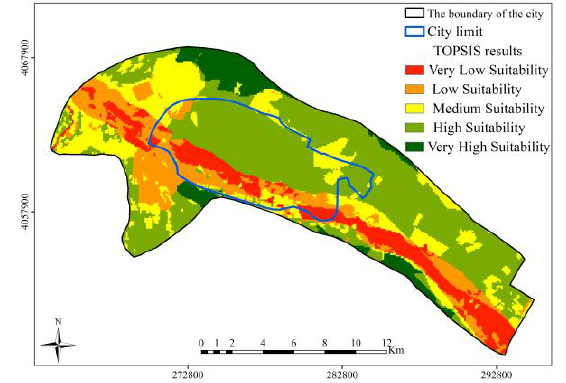
Figure 12. Classification of land suitability for physical development of the city using TOPSIS method based on CL